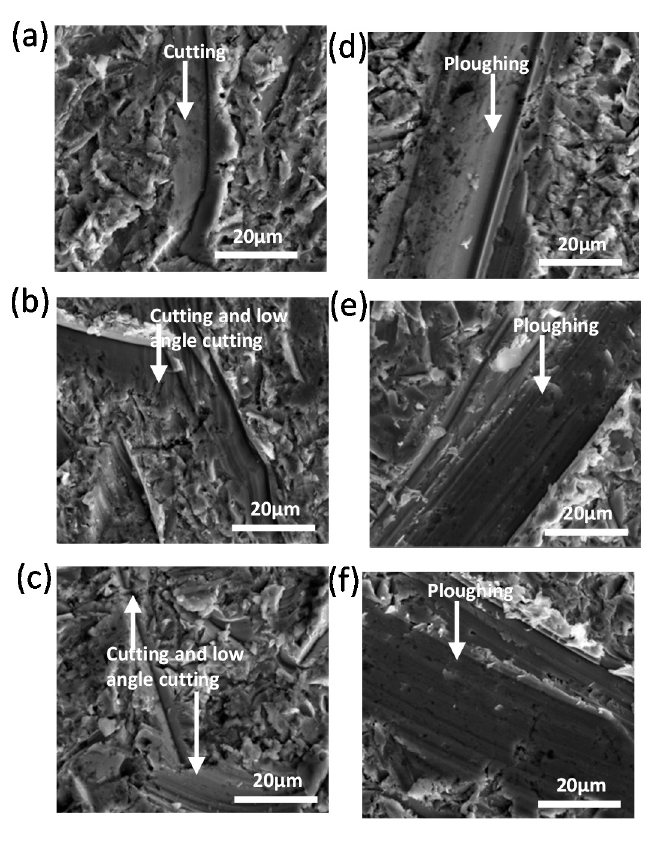
Figure 8. SEM micrographs of 60 m/s at 30° for ( a ) 10 s, ( b ) 300 s, and ( c ) 600 s, and at 90° for ( d ) 10 s, ( e ) 300 s, and ( f ) 600 s.